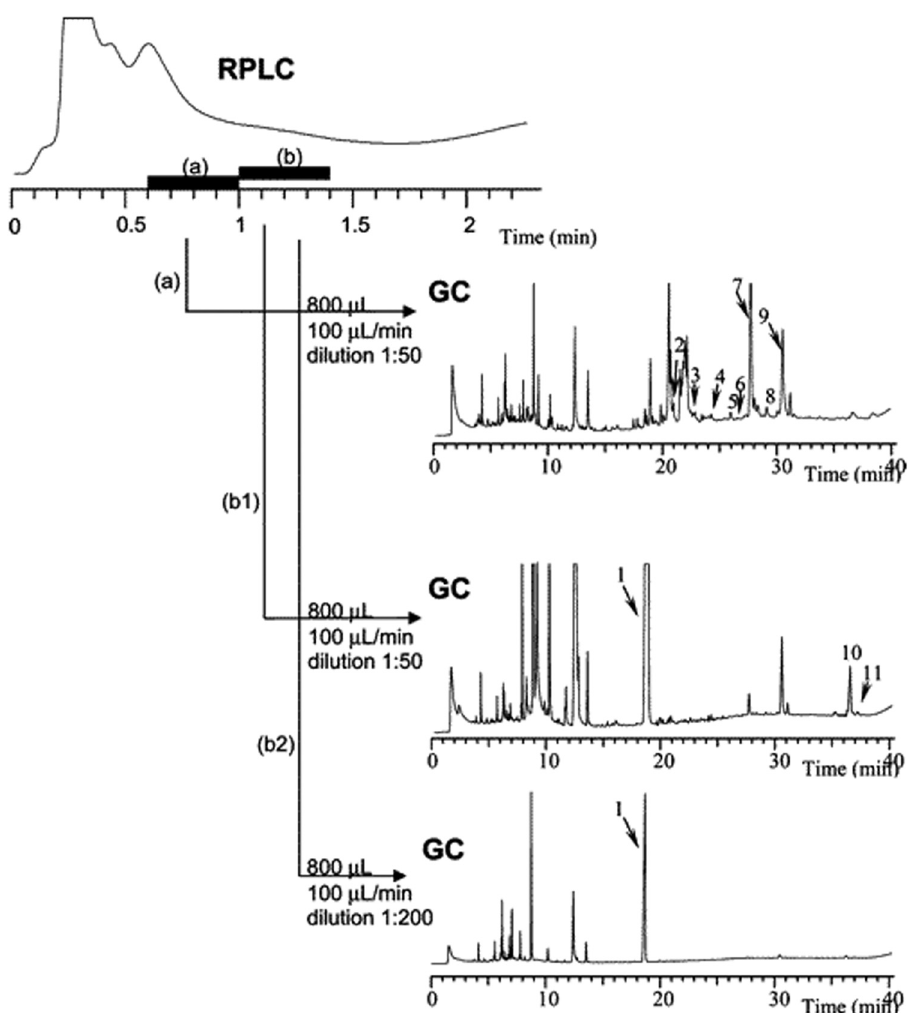
Figure 7: Gas chromatograms obtained from the direct RPLC - GC - FID analysis of the two fractions indicated in the LC chromatogram. Fraction ( a ) corresponds to sterols and tocopherols, and fraction ( b ) corresponds to squalene and triterpene dialcohols. Fraction ( b ) was analyzed twice: ( b1 ) olive oil diluted 1:50 in 2 - propanol and ( b2 ) olive oil diluted 1:200 in 2 - propanol. Reprinted with permission from ref. [ 58 ]